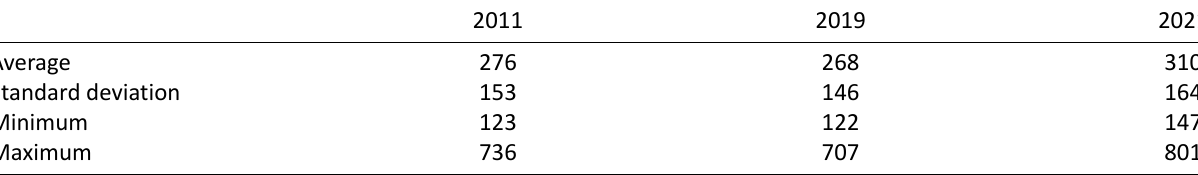
Table 1. Modified distributions of average residential values per cell ( × €1,000).